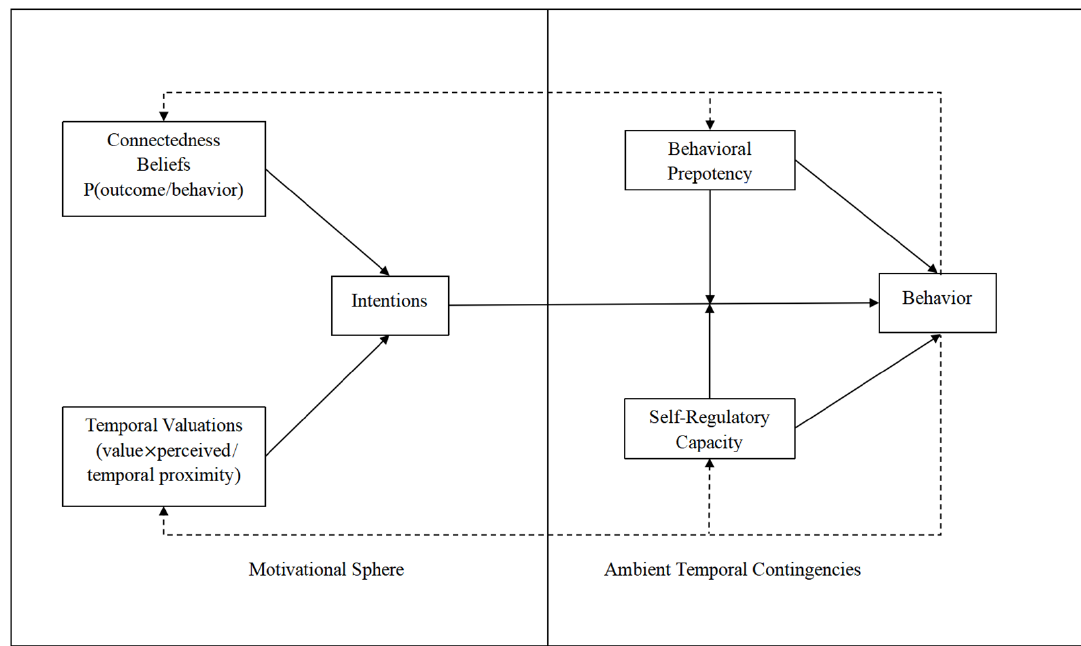
Figure 1. Mechanism of temporal self-regulation theory.